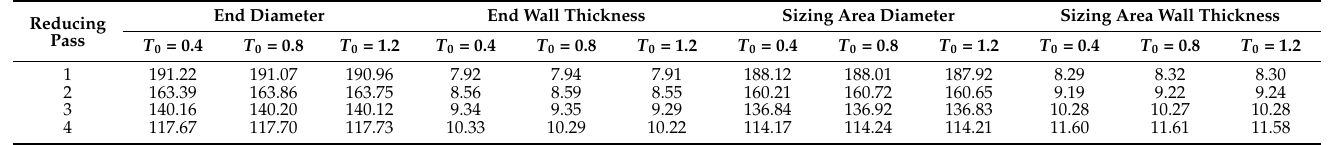
Table 5. Geometric parameters of reduced tube (mm).